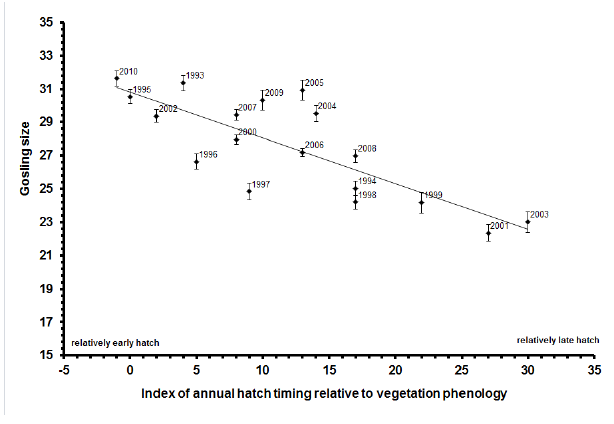
Fig. 3 . The relationship between gosling size at banding and hatch timing relative to forage plant phenology (after controlling for population density and total June and July rainfall) on Akimiski Island, Nunavut, from 1993-2010. Analyses were done on individual gosling size but the relationship depicted here is by mean annual size and 95% confidence limits (bars) for clarity.